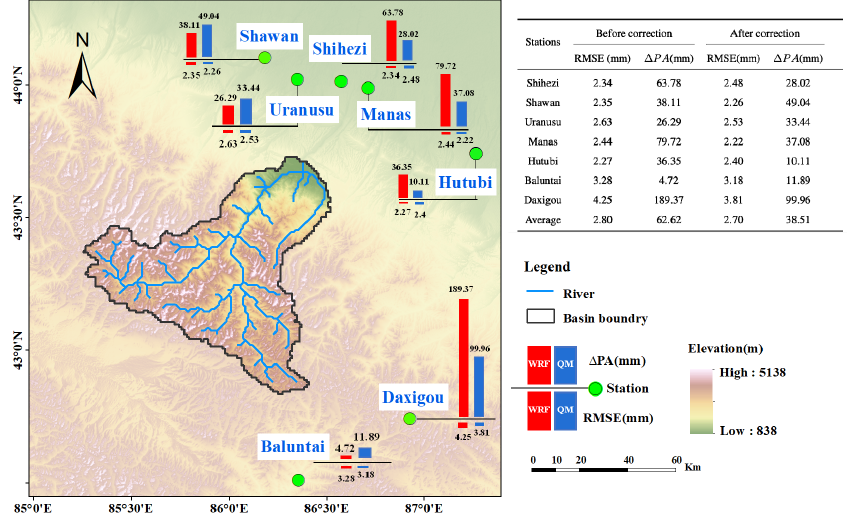
Figure 3. The accuracy ( ∆ PA and RMSE) of the WRF and QM precipitation datasets are illustrated in the Manas river basin map. The RMSE and ∆ PA are marked as bar charts in which red color represents the accuracy of the WRF precipitation and the blue represents the QM